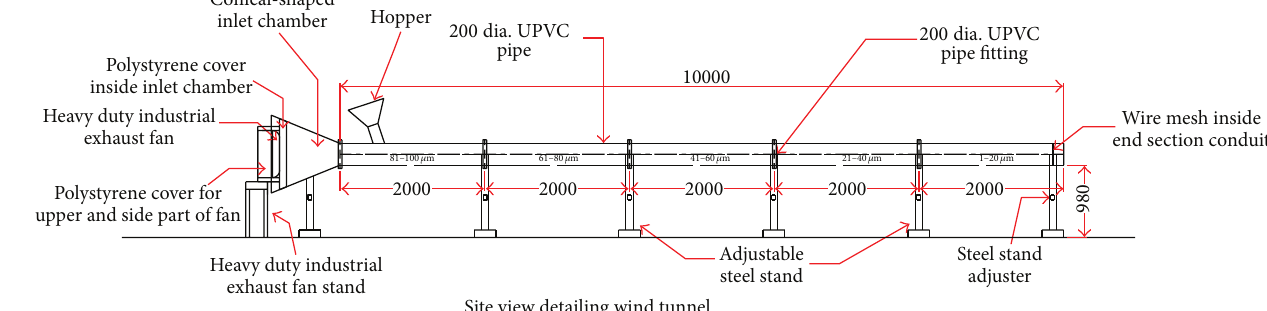
Figure 1: 2D schematic drawing of the finalized wind tunnel production system.